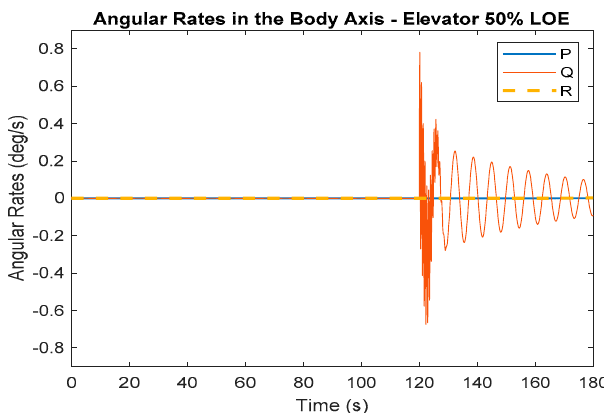
Figure 7. Angular rates in the body axis for the elevator 50% LOE fault.